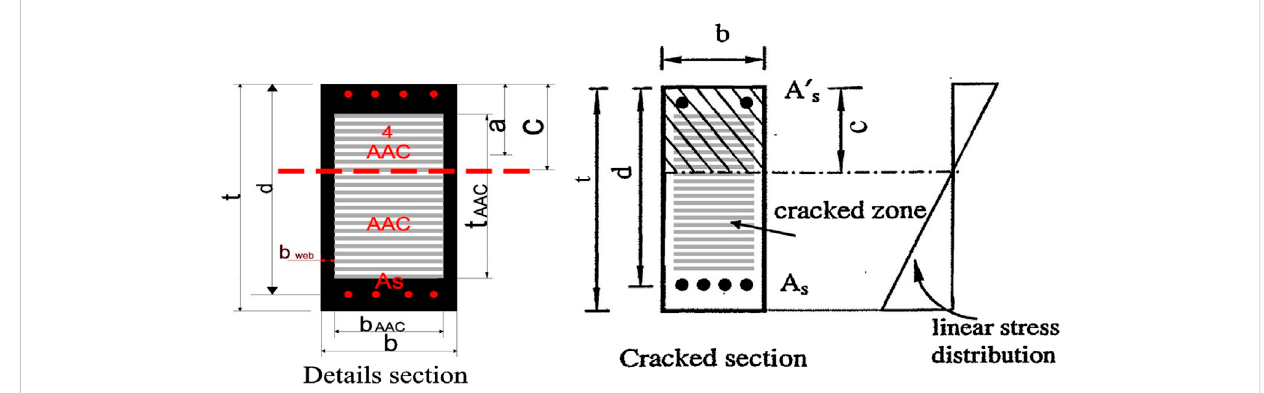
Cracking of the concrete section under applied loads.